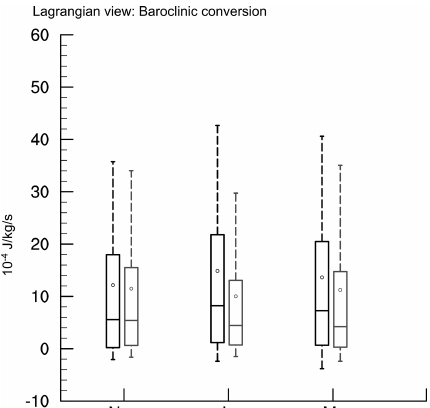
Figure 8. Box-and-whisker diagram for baroclinic conversion at 500hPa (10 − 4 Jkg − 1 s − 1 ) averaged within a radius of 1000km around the surface-cyclone centers that enter the target region in Fig. 7 from upstream before (black) and after (gray) passing the latitude of maximum deepening (black dashed line in Fig.